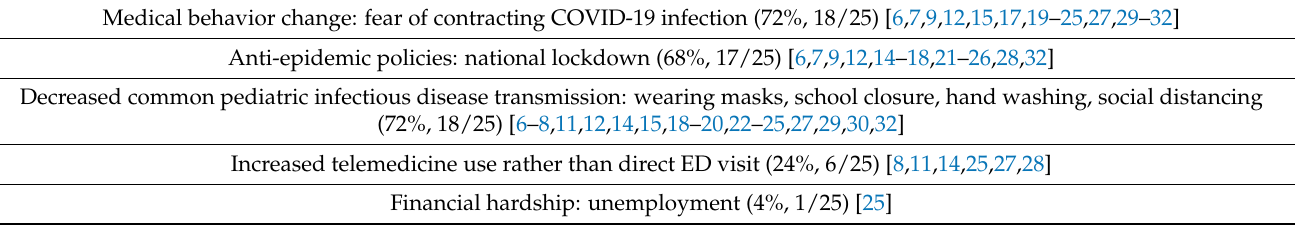
Table 3. Contributory factors to reduced pediatric emergency department